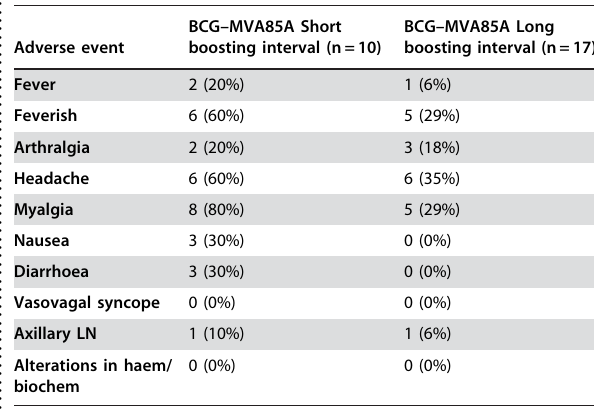
Table 1. Demographic details of subjects according to trial. The data for the middle column (long-boost interval) derive